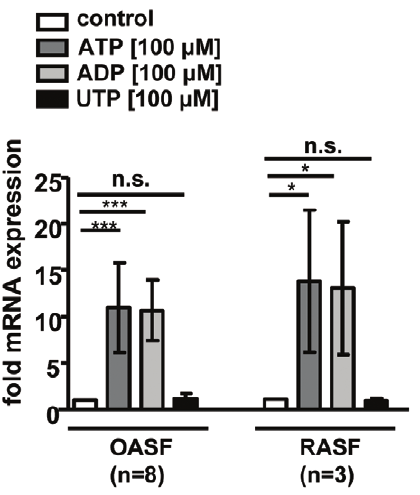
Figure 2. Purinergic receptor P2X, but not P2Y agonists induce BDNF expression. OASF (n=8) and RASF (n=3) were stimulated for 2 h with 100 m M ATP, ADP and UTP, respectively. BDNF mRNA expression was increased by ATP and ADP, but not by UTP. Data are shown as means 6 standard deviations. N.s., not significant; *, p , 0.05, ***, p ,